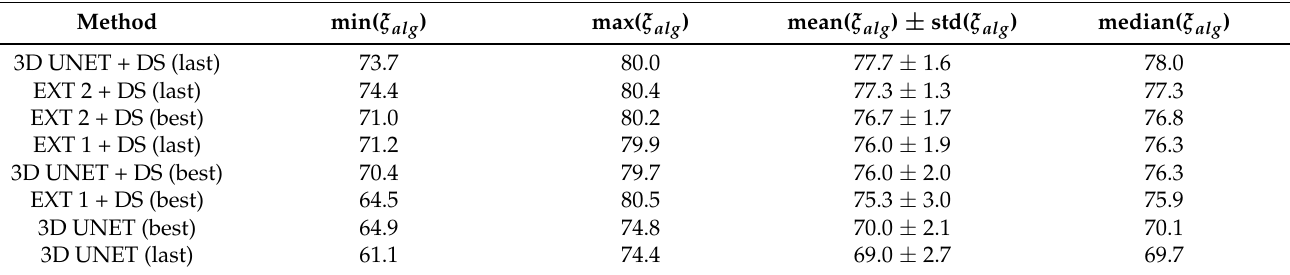
Table 1. Effectiveness of the proposed follicle detection methods trained and evaluated 50 times on the USOVA3D database. Minimum, maximum, mean and median of the overall algorithm’s score are presented over 50 runs. Entries are sorted with respect to the median